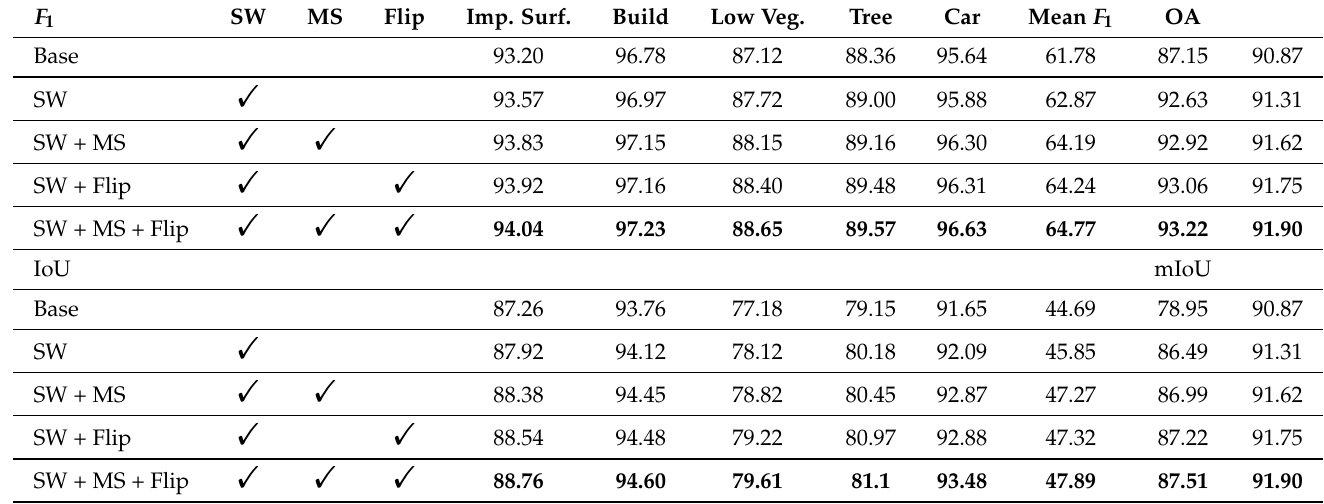
Table 11. Performance of different testing methods on the Potsdam